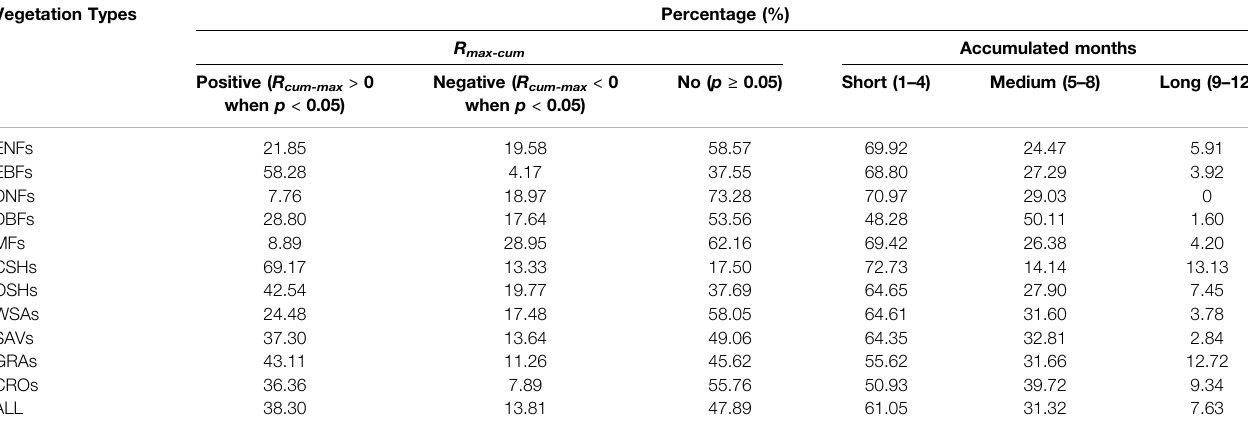
TABLE 1 | Percentages of different R max-cum (i.e., positive, negative, and no signi fi cant correlation) and accumulated months (i.e., short, medium, and long term) across vegetation types. Vegetation Types